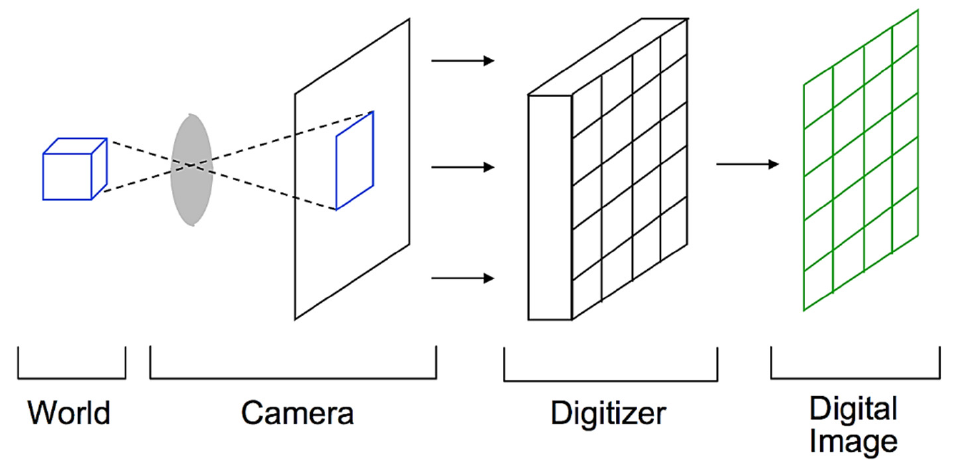
Figure 3. Image acquisition steps.